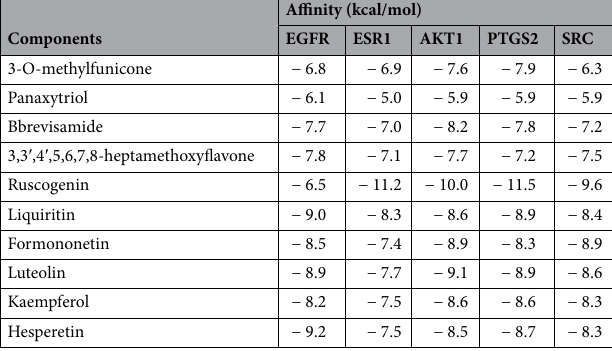
Table 4. The binding energy of the core components and targets.